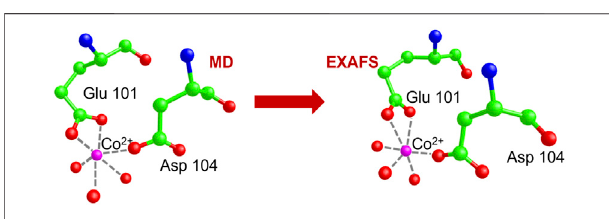
FIGURE11| ComparisonoftheCo.bindingsitecon fi gurationattheend of the MD simulation and after the EXAFS fi tting step. The color code is as shown in Figure 9 . Hydrogen atoms are not shown as they are standardly considered not to contribute to the XAS signal. Broken lines represent the distances of Co 2+ from its six oxygen ligands.